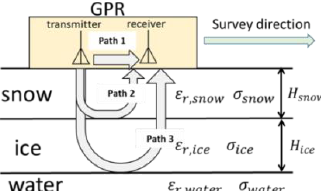
Figure 1. Skematic view of ice thickness measurement.